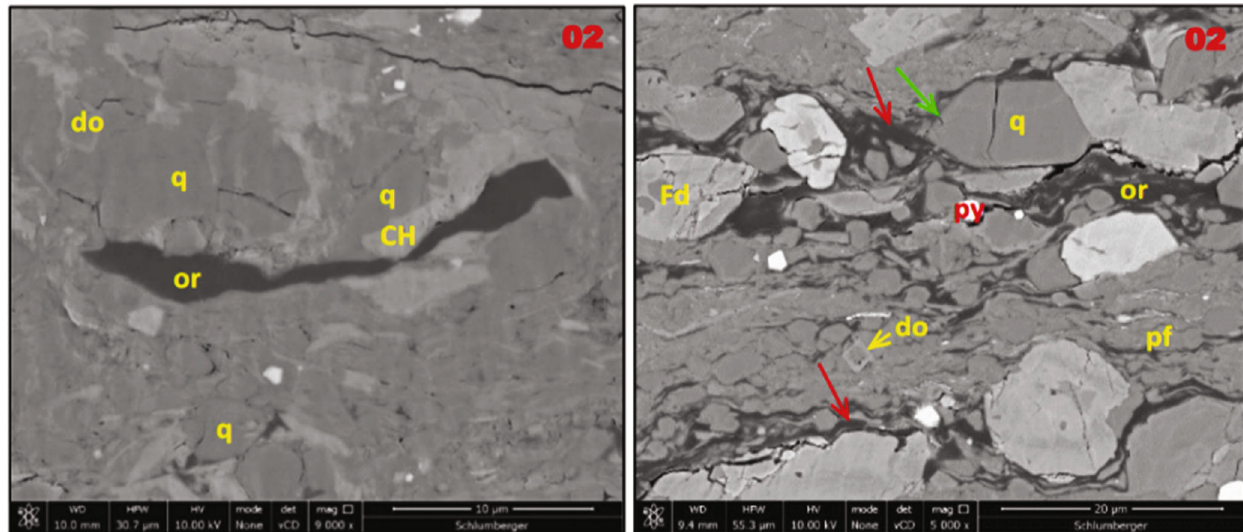
Figure 1: Multistage micro scale natural fracture system of an unconventional reservoir (after the polishing of argon